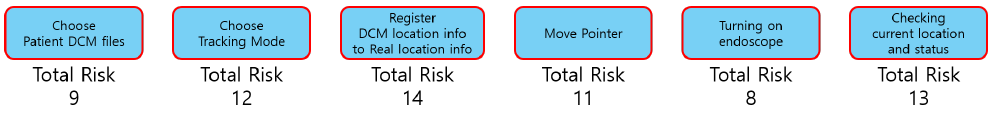
Figure 10. Identification of critical tasks in risk analysis.